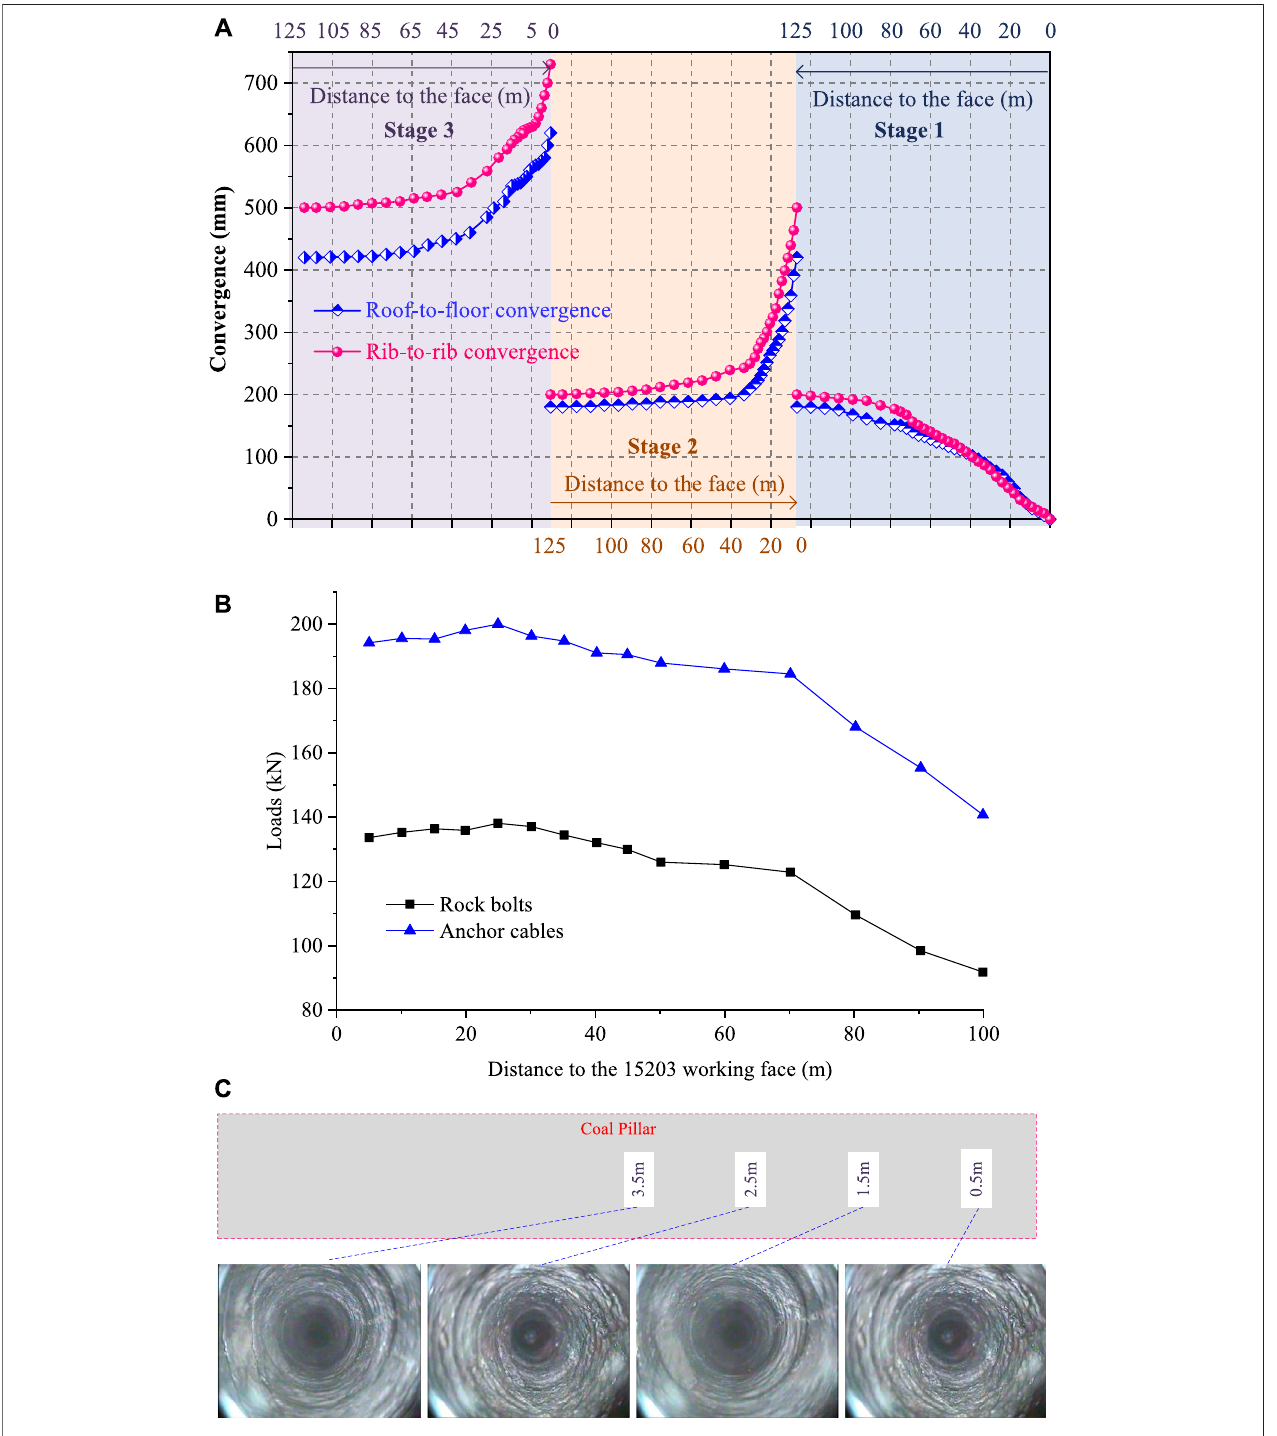
FIGURE13| Deformation and crack features ofthe W1309 tailgate under the optimized support scheme. (A) Deformationofthe newly excavated W1309tailgate; (B) Loads of rock bolts and anchor cables in coal pillar during repeated mining; (C) Crack propagation features of coal pillar 10 m ahead of working face.